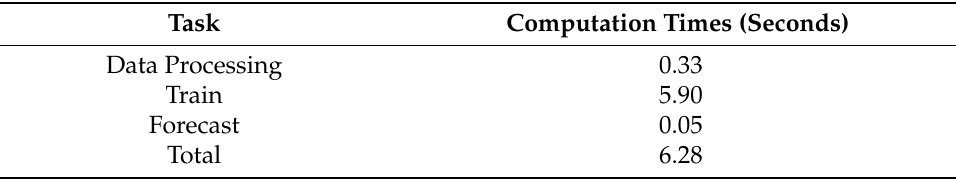
Table 5. Computational times for a PV forecast run considering one year of historical